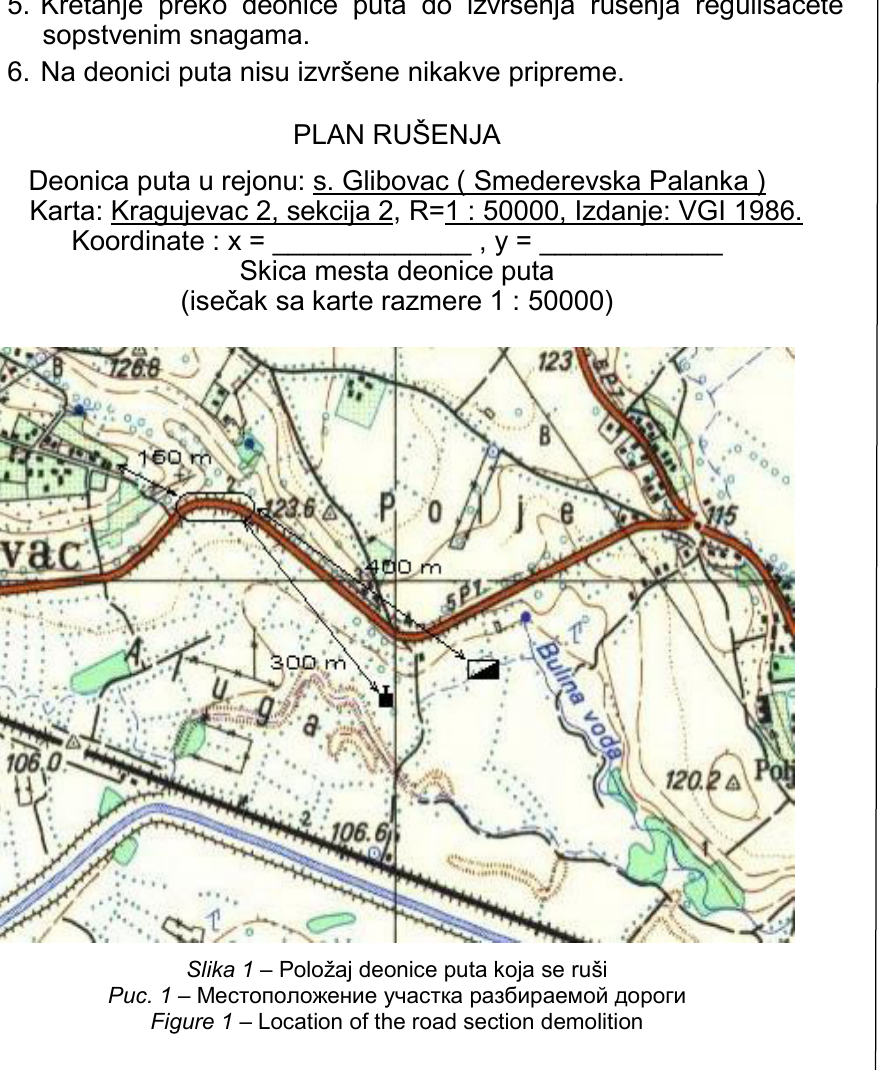
Figure 1 – Location of the road section